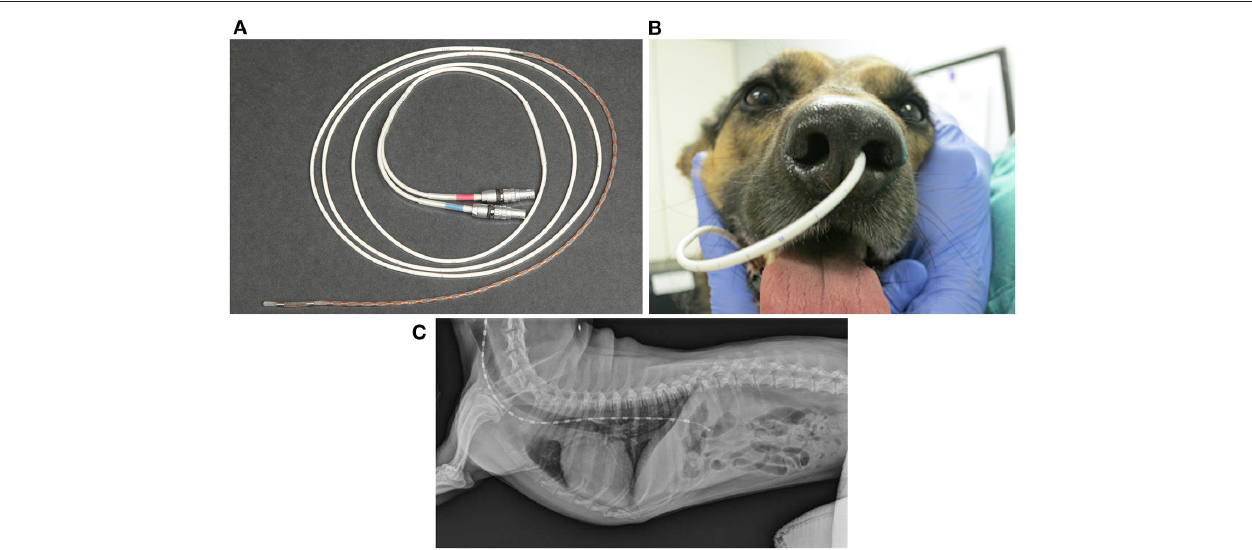
FIGURE 8 | Implementation of high-resolution manometry in dogs. (A) A coiled 8Fr high resolution manometric (HRM) solid-state catheter with 36 circumferential pressure sensors spaced 1cm apart, lining the end of the catheter. The red and blue labeled connectors plug into the manometry hardware module, which transmits information to the manometric data acquisition software that runs on a computer. (B) A picture of the HRM catheter successfully placed transnasally into the left nasal passage of a 4-year-old, 18-kg, mixed breed dog. (C) Survey lateral thoracic radiographic view of a 7.2-kg terrier cross after placement of a high-resolution manometry probe. In this dog, the probe traverses both the UES and LES. The brighter rectangular regions spaced equally along the probe represent each of the 36 probe sensors. (C) was reprinted from American Journal of Veterinary Research, Volume 77, Ullal TV, Kass PH, Conklin JL, Belafsky PC, Marks SL, High-resolution manometric evaluation of the effects of cisapride on the esophagus during administration of solid and liquid boluses in awake healthy dogs, Copyright 2016 American Journal of Veterinary Research. Reprinted with permission from American Veterinary Medical